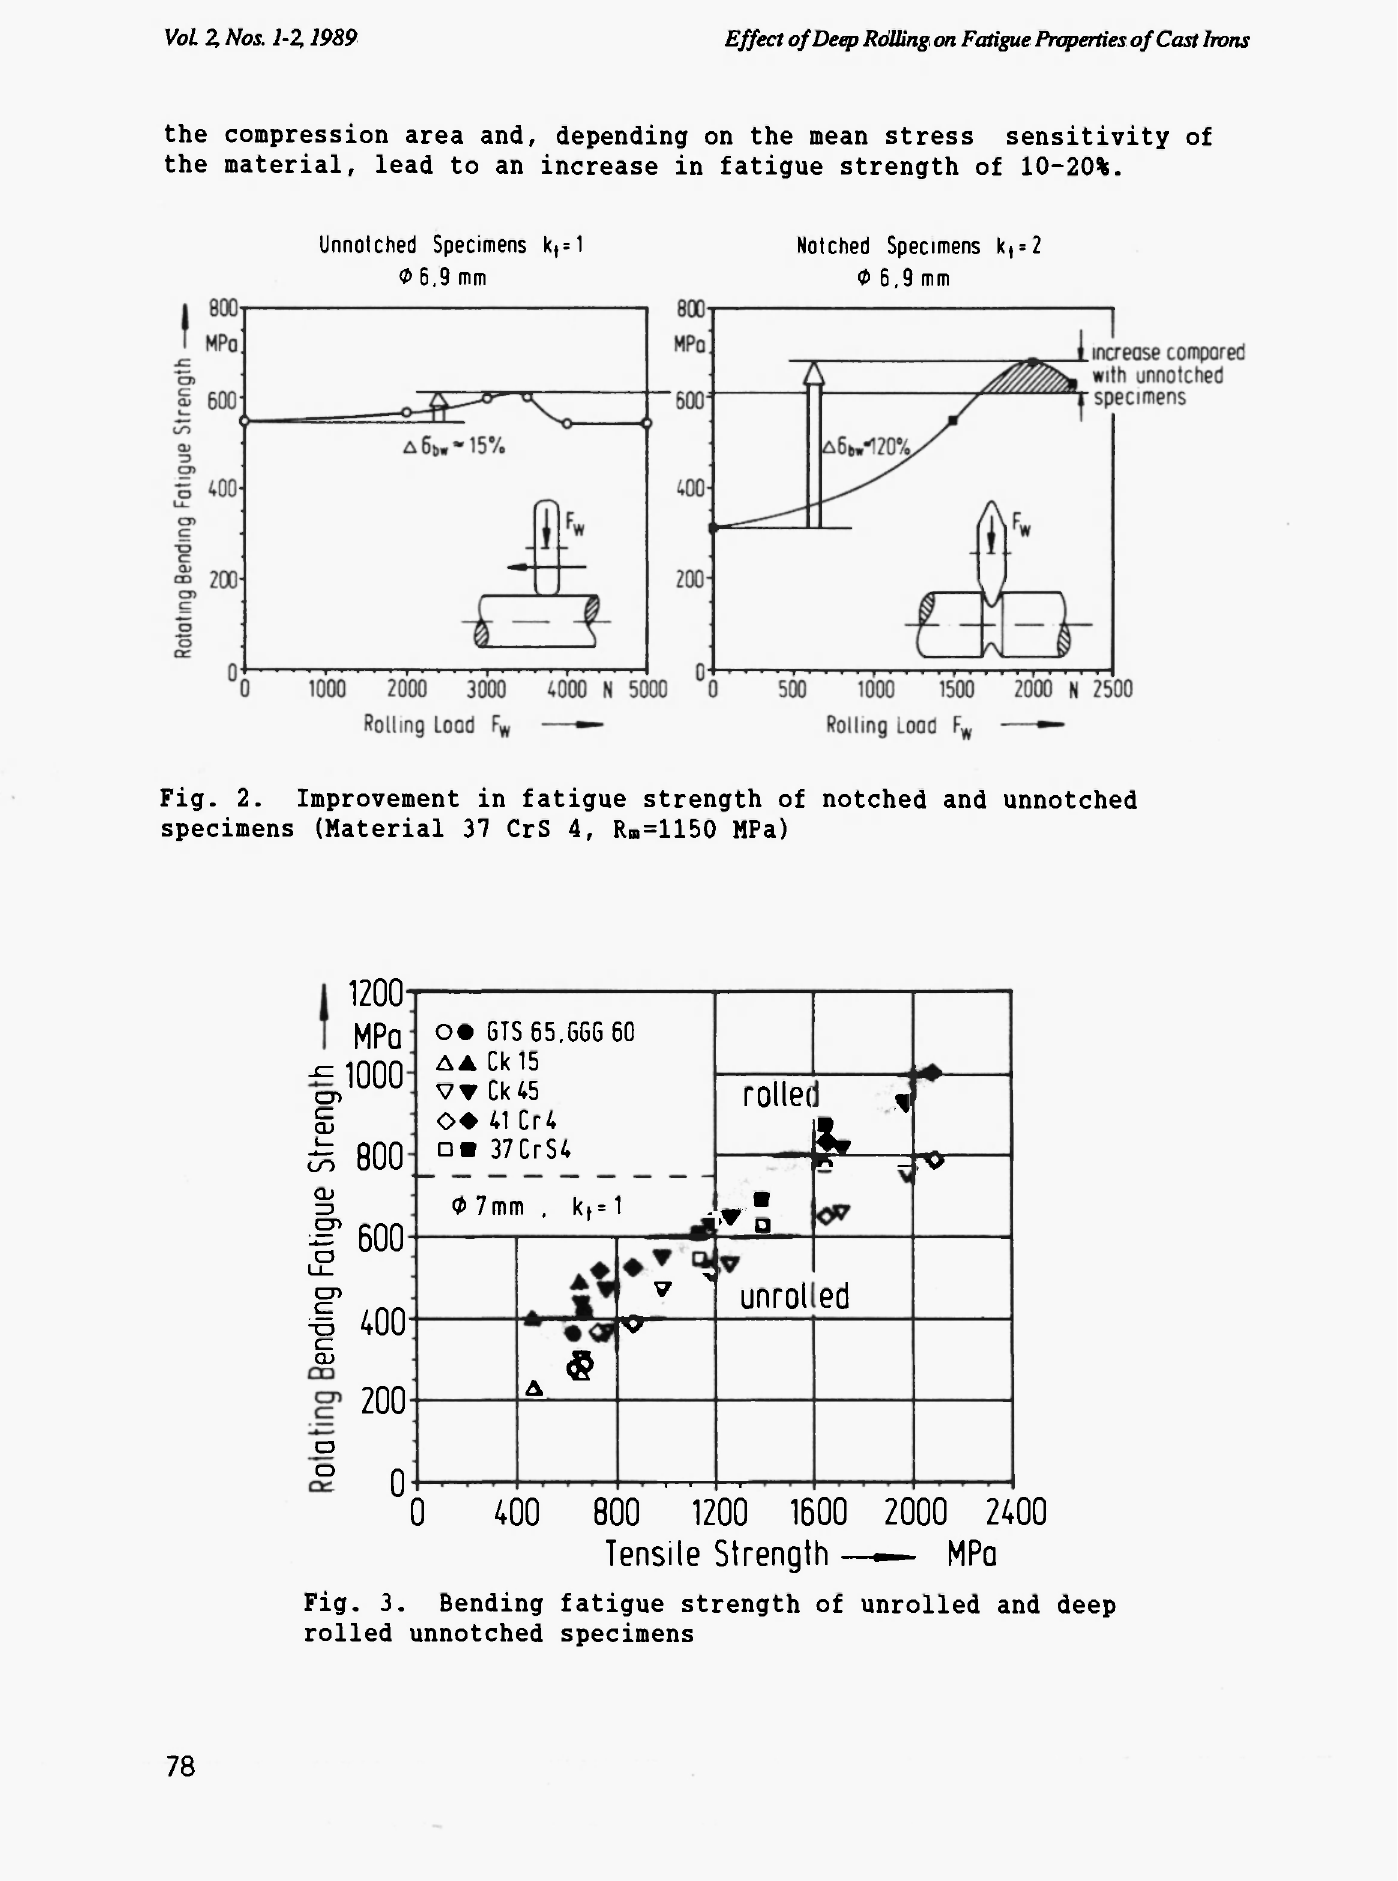
Fig. 2. Improvement in fatigue strength of notched and unnotched specimens (Material 37 CrS 4, Rm=1150 MPa)